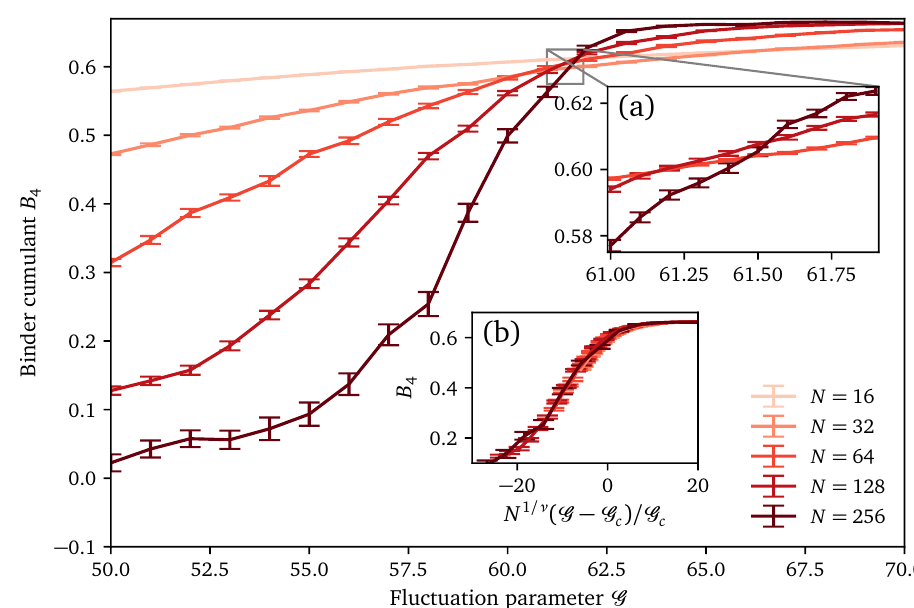
Figure 11: Phase transition. Binder cumulant as defined in Eq. (41) as a function of the fluctuation parameter G for different system sizes, where the inflexion point as determined from the largest system sizes in inset (a) reveals the critical fluctu- ation parameter to be G 61.4 in agreement to previous studies [ 47 ] . Rescaling c ≈ all curves as shown in inset (b) with the known critical exponent ν = 1 for the 2D Ising universality class leads to a good collapse over a large parameter regime. Lines connecting data points are solely a guide for the eyes. Error bars are obtained from a jackknife binning